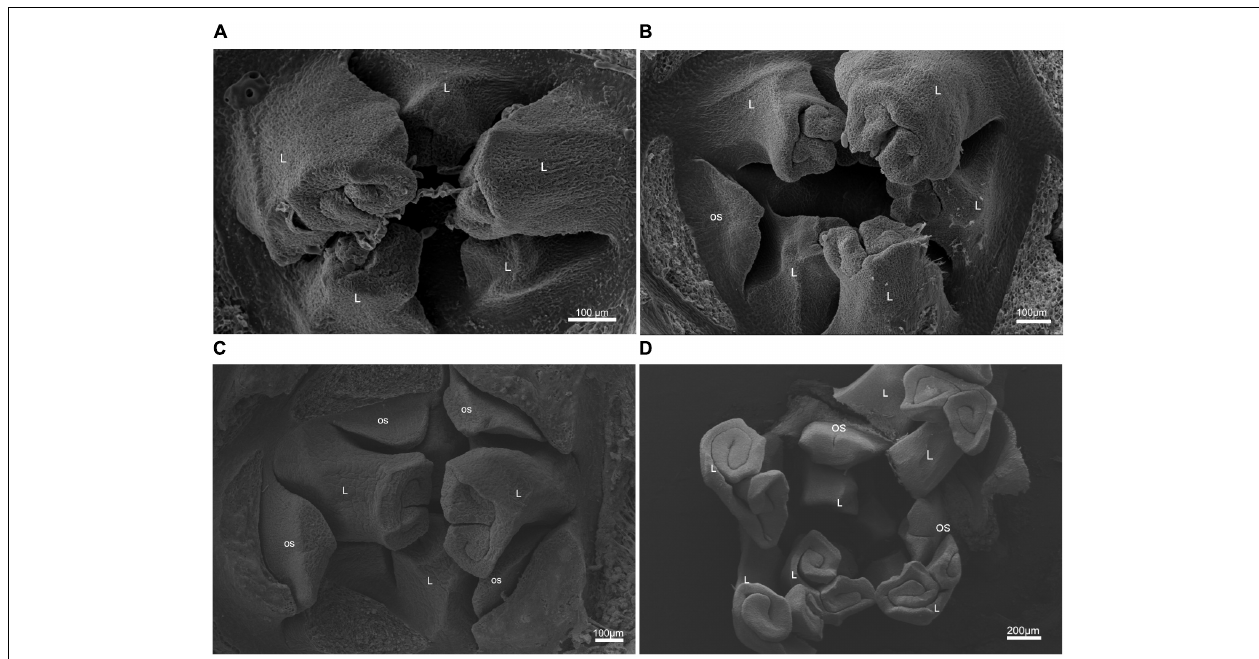
FIGURE 1 | Morphology of the female strobilus buds of ginkgo at three developmental stages was observed using scanning electron microscopy (SEM). (A) At the vegetative stage (ST1), 3–7 leaf primordia curl inward in the buds but no ovule stalk appeared. (B) At the initial differentiation stage (ST2), an ovulate stalk primordium is initiated at the axils of a leaf primordium. (C) At the early exuberant differentiation stage (ST3-1), multiple ovulate stalk primordia appear. With the enlargement of ovulate stalk primordia, some of them take on frontally laminar shapes (D) . At the late exuberant differentiation stage (ST3-2), a longitudinal furrow becomes evident on the distal abaxial side of some ovulate stalk primordia. L, leaf primordium; OS, ovulate stalk